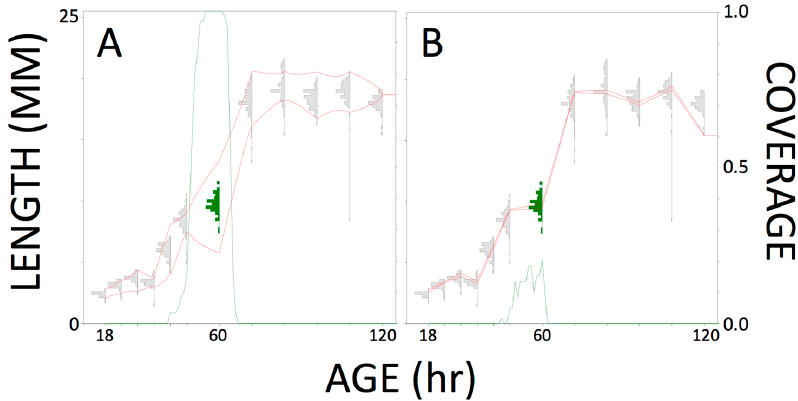
Figure 1. Blow fly growth data illustrating how inverse prediction model performance can depend on the design of the training data experiment. The histograms show the complete data set ( n = 1405) of larval length as a function of age. The inverse prediction model (red lines defining a growth curve) reflect published sampling methods and were calculated based on subsamples of 10 from each cohort that were ( A ) randomly selected or ( B ) the largest individuals. Each green peak shows the coverage proportion for 95% prediction intervals on age from length for each larva in the 60 h cohort. Model A performed relatively well in that 100% of predictions included the true age and the line falls away steeply on each side. Model B performed poorly. From [18].